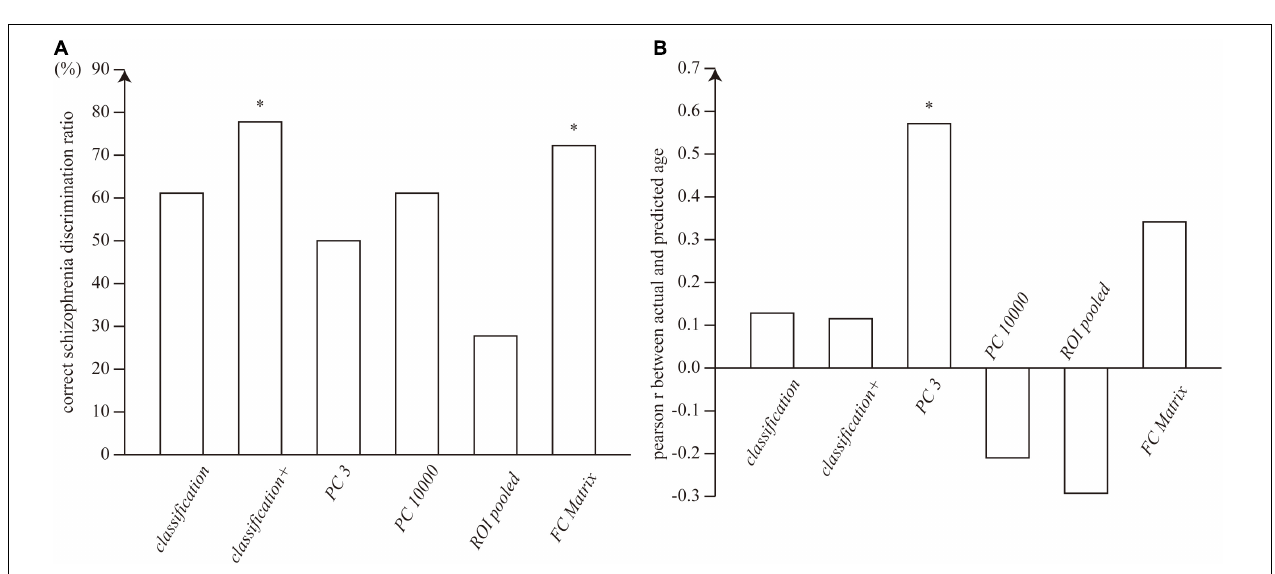
FIGURE 2 | (A) Distribution of feature vectors, visualized by t-SNE. Each dot represents a feature vector for a single timepoint, colored for each subject. (B) Precision@150 of the cluster for each feature vector.